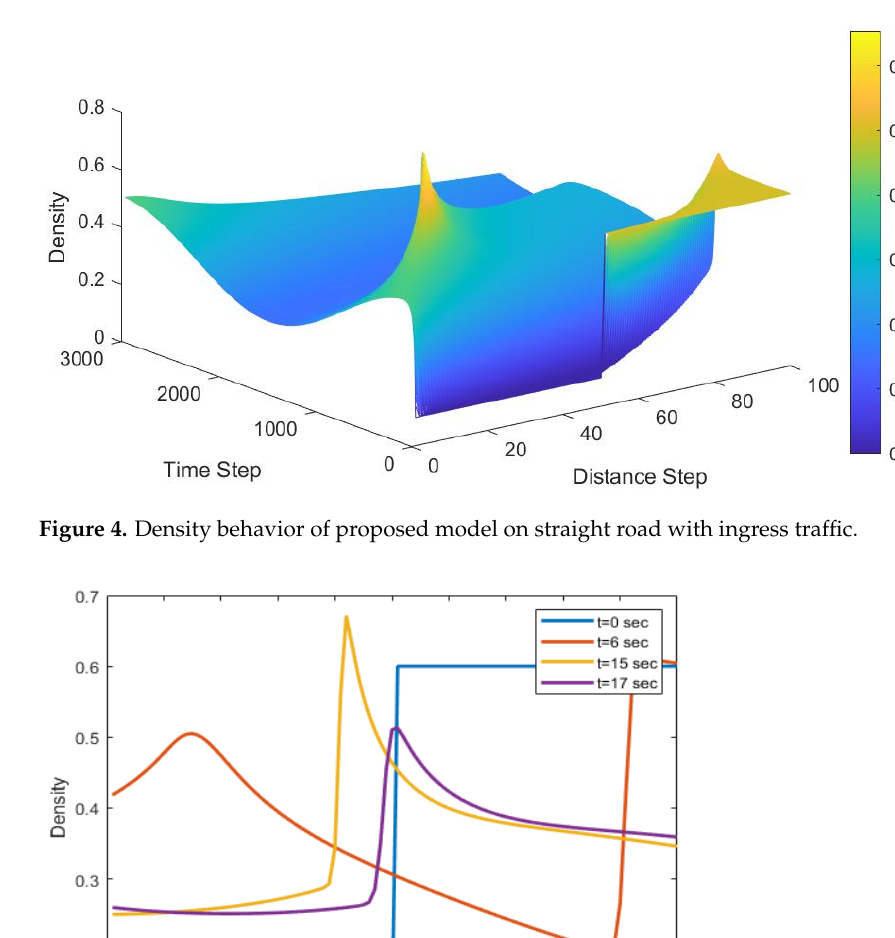
Figure 3. Velocity behavior of PW model on straight road with ingress traffic.